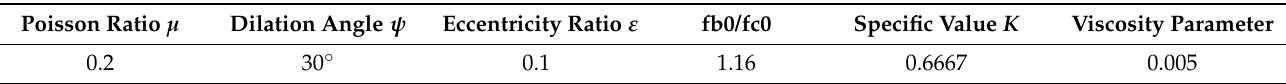
Figure 2. Stress ‐ strain relationship of steel. Figure 2. Stress-strain relationship of steel. Table 2. C40 Concrete material